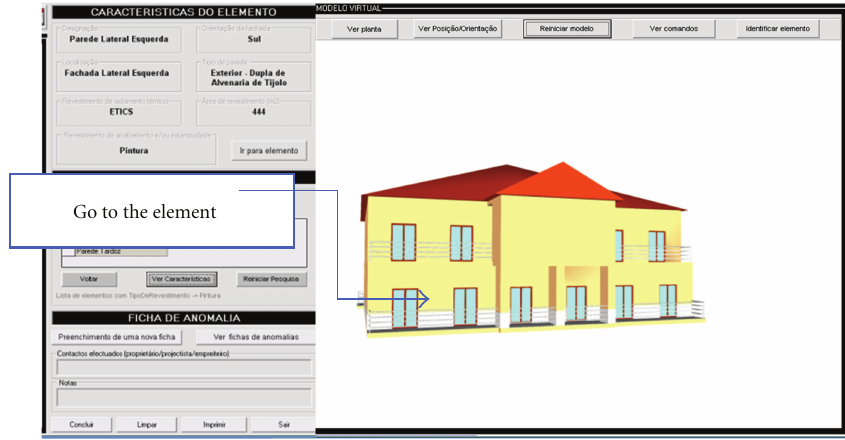
Figure 14: Identification of a fac¸ade element.